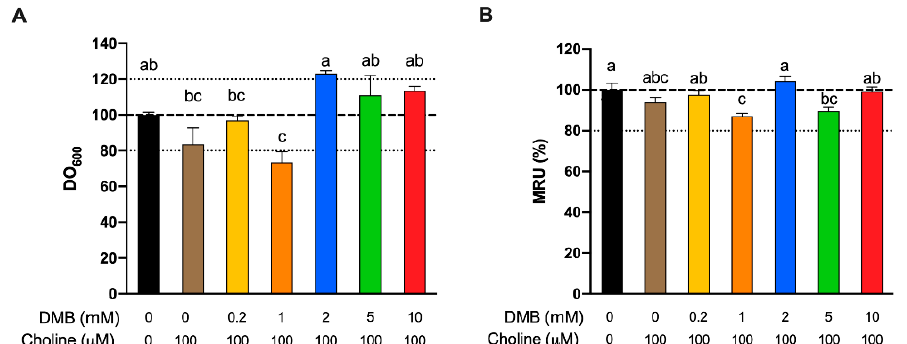
Figure 6. Relative approximate cell count (600 nm optical density) fermentations at 24 h as a % of DMB-free choline-free conditions ( A ). Relative changes in mitochondrial respiration units (MRU) at 24 h as a % of DMB-free choline-free conditions ( B ). All fermentations were carried out with fecal slurry 20%. Results are expressed as mean (%) ± SEM ( n = 6). Different letters indicate statistical differences ( p < 0.05) by one-way ANOVA (Tukey’s post hoc